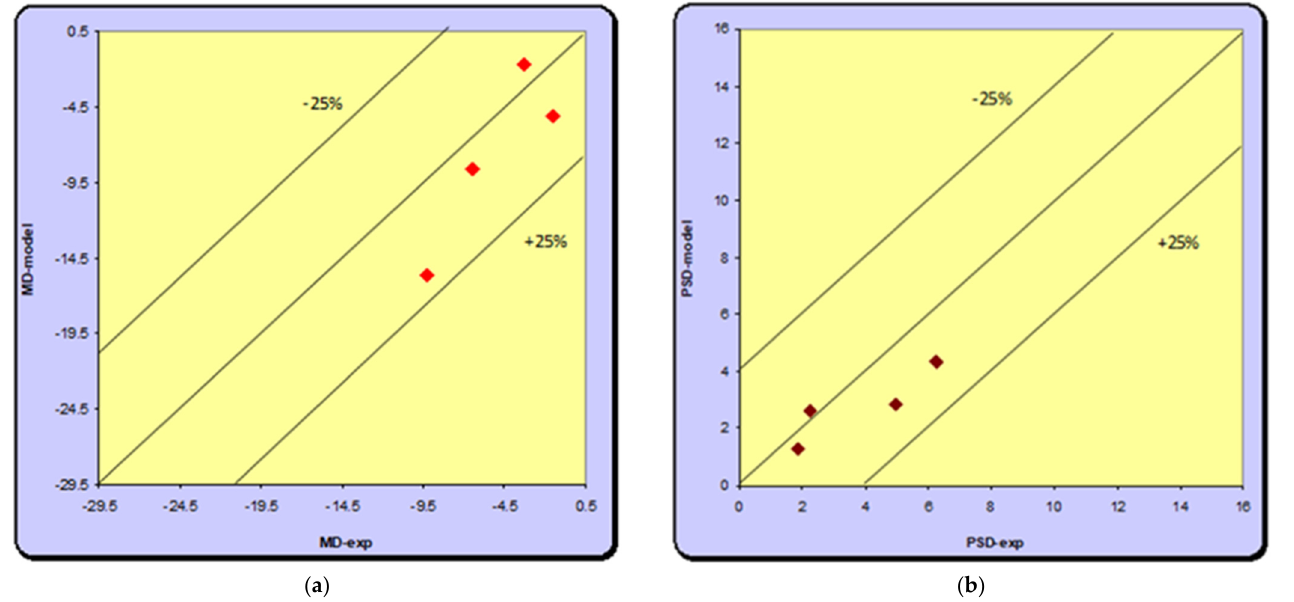
Figure 7. Comparison of experimental results with those provided by the ANN network (21: 35: 4) for ( a , b ) predictions (MD, experimental PSD).